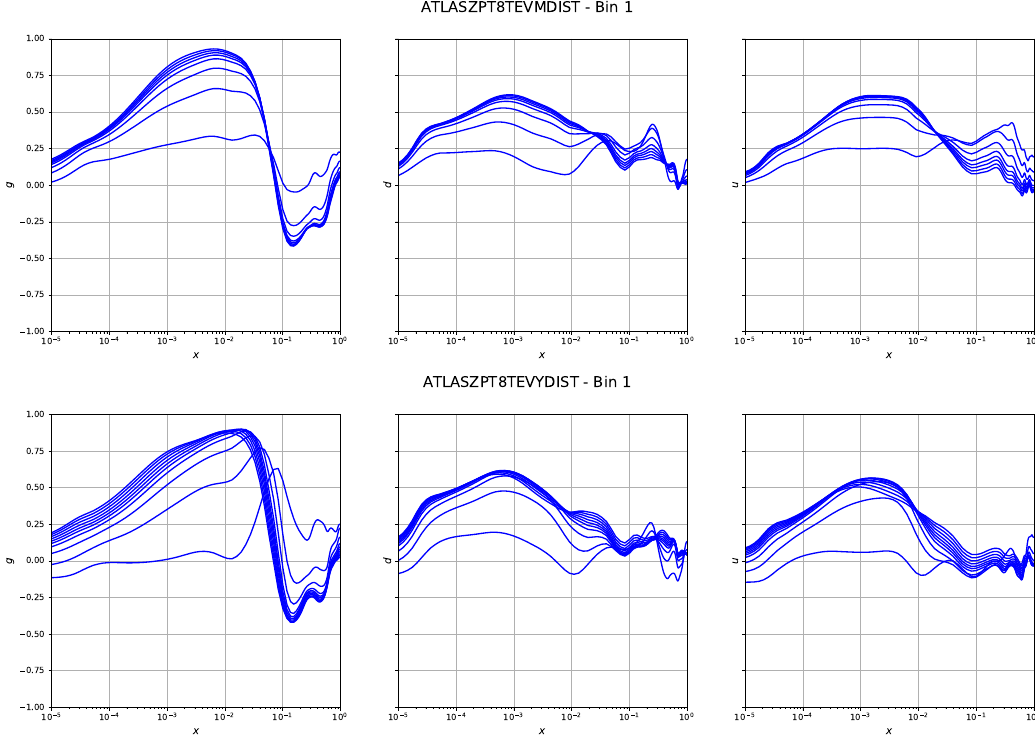
Figure 8 . Top row: correlations between the ATLAS 8 TeV p Z mass of the lepton pair and the gluon, up- and down-quark distributions as a function of x ( p Z 1; 12 GeV < M ll < 20 GeV; 0 : 0 < j Y Z j < 2 : 4). Bottom row: correlations between the ATLAS 8 TeV p Z measurement in the Z -peak invariant mass bin, binned in rapidity of the vector boson and the T gluon, up- and down-quark distributions as a function of x ( p Z 0 : 0 < j Y Z j < 0 :